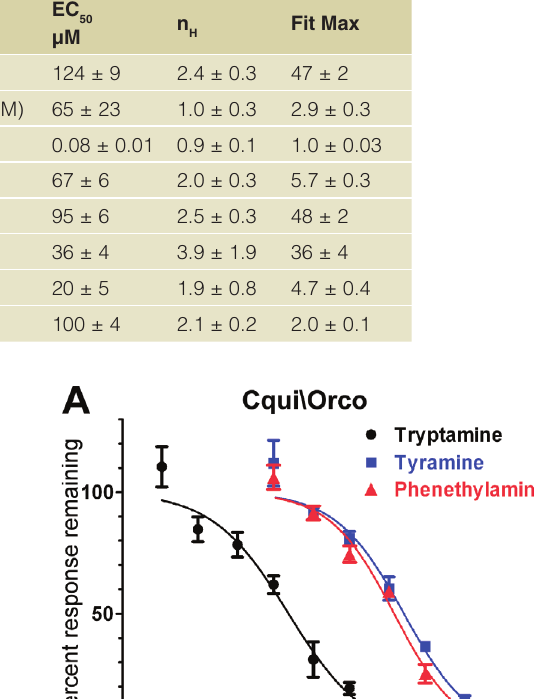
Table 1. Odorant and Orco agonist concentration-response curve values for Orco homomers and heteromeric ORs from several insect species. Concentration-response data was fit as described in Methods. n is the apparent Hill coefficient. Values are presented as mean H ± SEM (n = 3-14). Ligand Receptor (Normalizing Conc.)